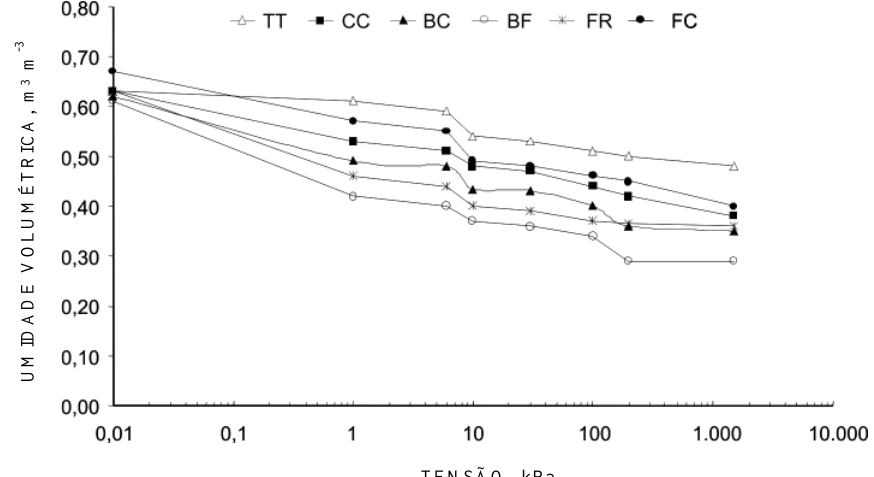
Figuras 6. Curvas de retenção de água de um Latossolo Amarelo (0–3 cm), sob diferentes classes de perturbação (TT-trilha do trator; CC-centro da clareira; BC-borda da clareira/floresta; BF-borda da floresta/clareira; FR-floresta remanescente e